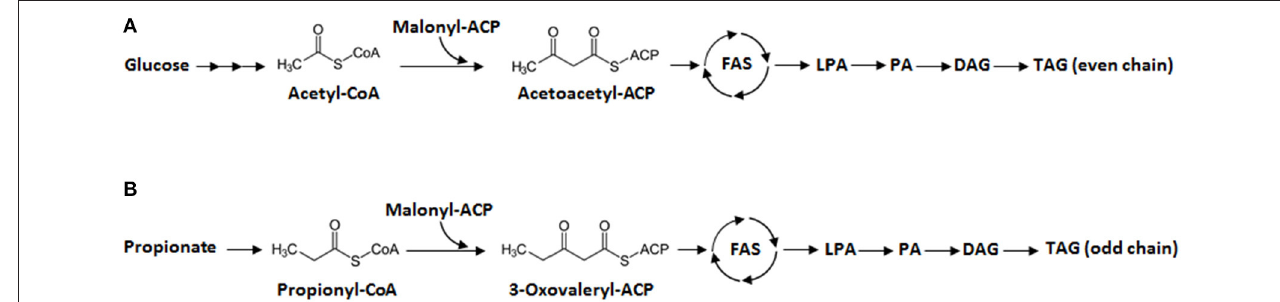
FIGURE 1 | Lipid synthesis in Y. lipolytica . (A) Synthesis of even-chain fatty acids (FAs) from glucose. (B) Synthesis of odd-chain FAs from propionate. First, there is elongation of fatty acyl-CoA by fatty acid synthase (FAS). Second, the resulting even- or odd-chain fatty acyl-CoA is transformed into lysophosphatidic acid (LPA), phosphatidic acid (PA), and diacylglycerol (DAG), in that order, before finally forming triacylglycerol